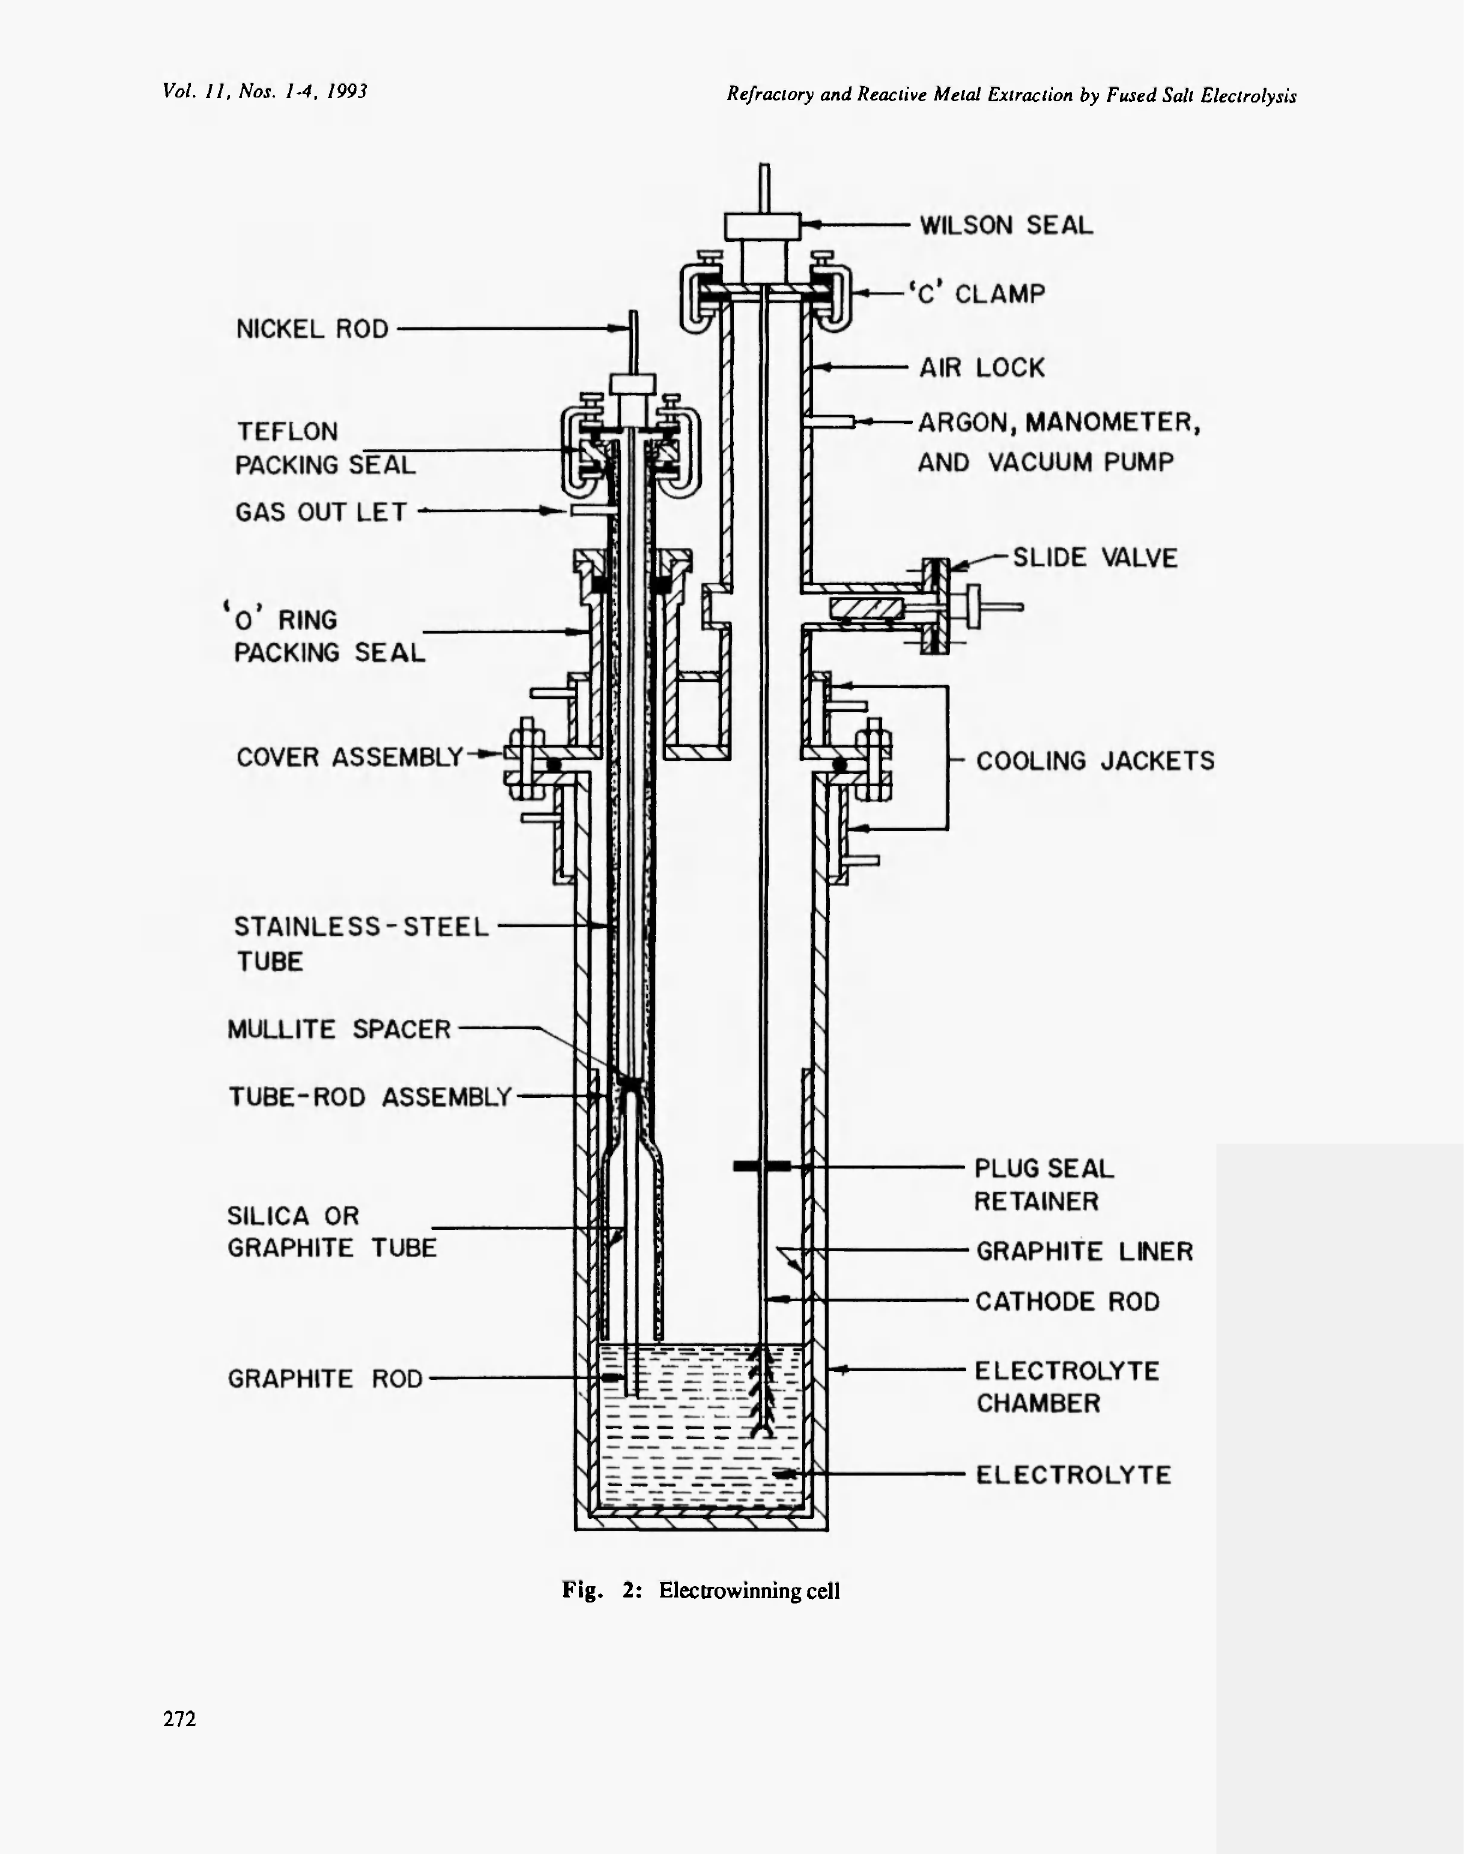
Fig. 2: Electrowinning